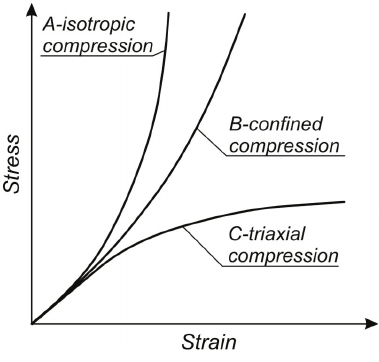
Fig. 12. Comparison of different stress-strain